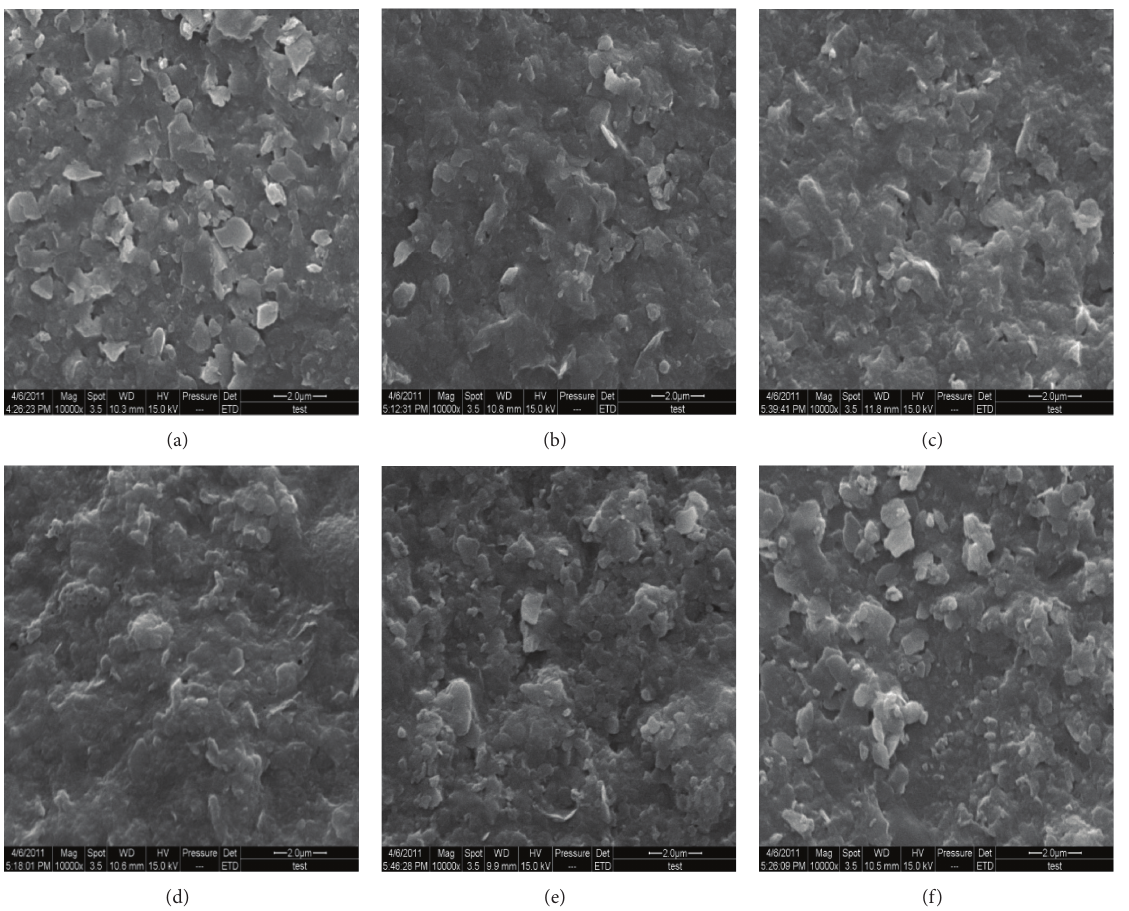
Figure 3: Scanning electron microscopy images of soil colloids with (b, d, and f) and without (a, c, and e) fungus extract addition. The labels are the same as those for Figure